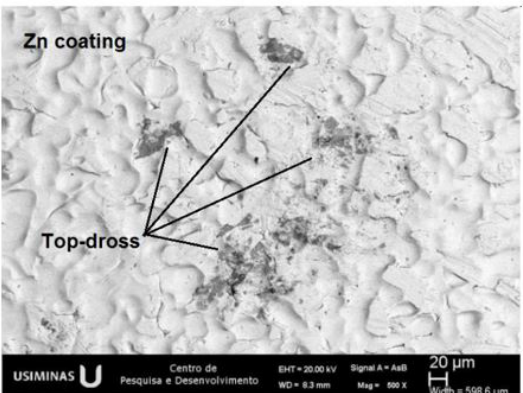
Figure 18. Surface aspect of the coating with top-dross particle with 500X